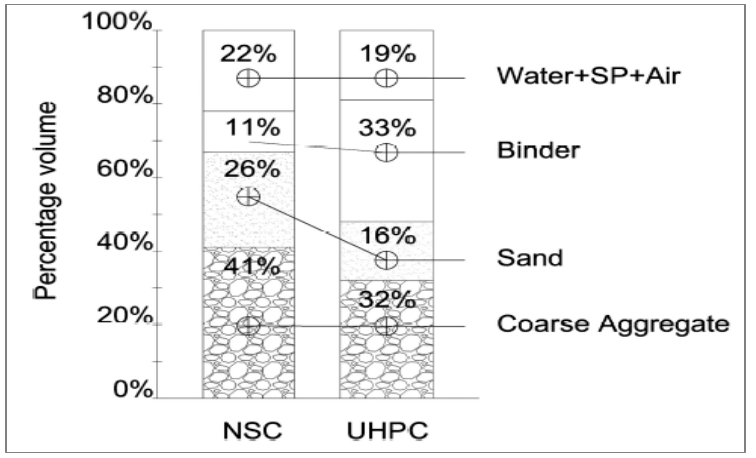
Figure 1. Aggregates for NHS and UHPC